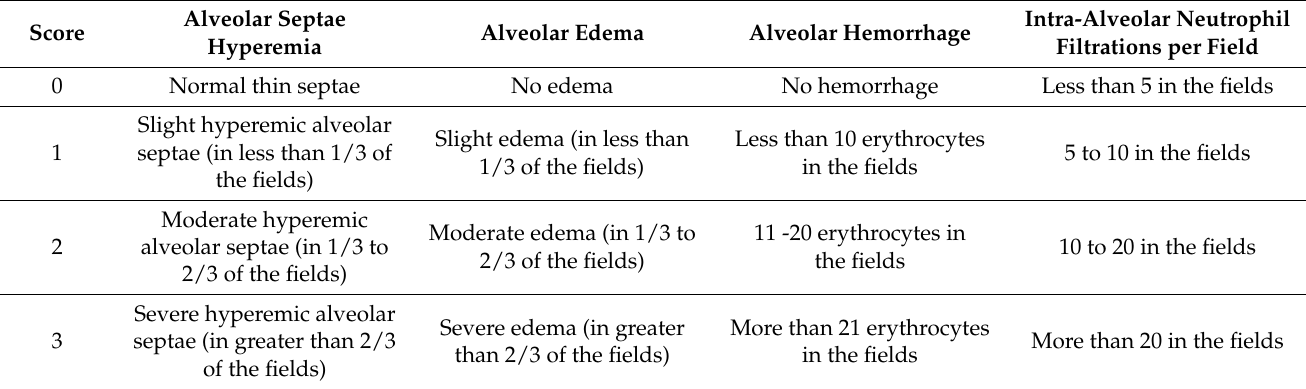
Table 1. Histopathological score criterion for